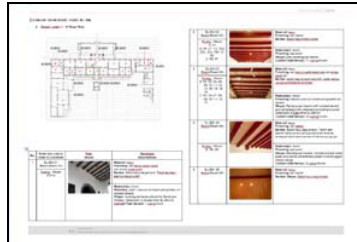
Figure 1. Sample of Identification document. It shows key plan and list of building elements.